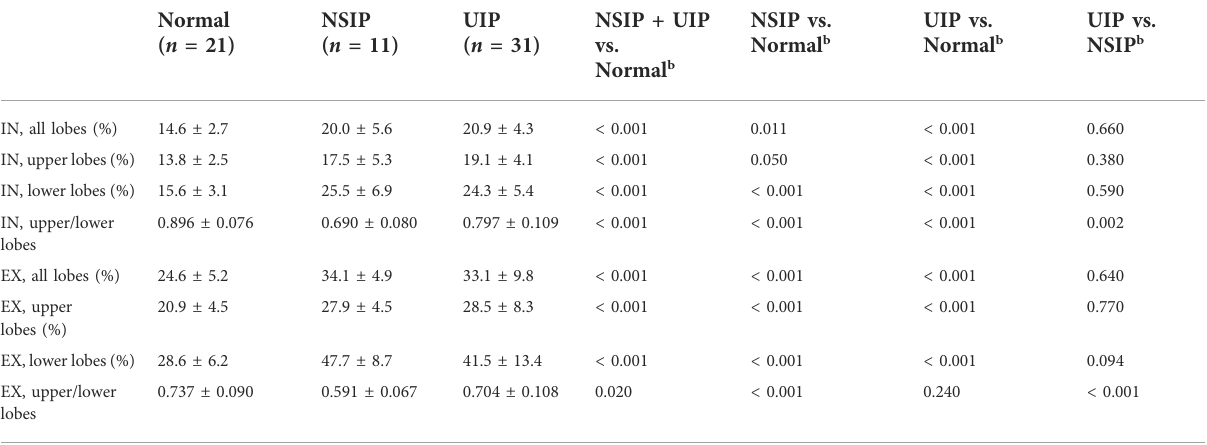
TABLE 3 Comparison of TFs between normal, NSIP, and UIP